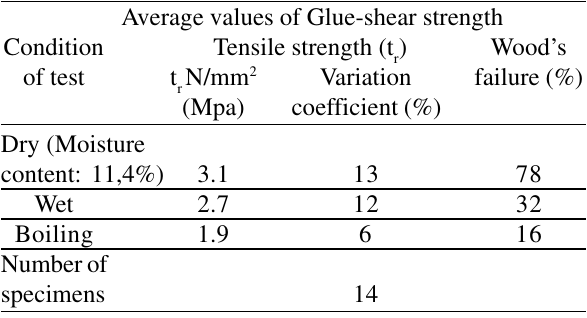
Table 4. Results of the plywood’s glue-shear strength.